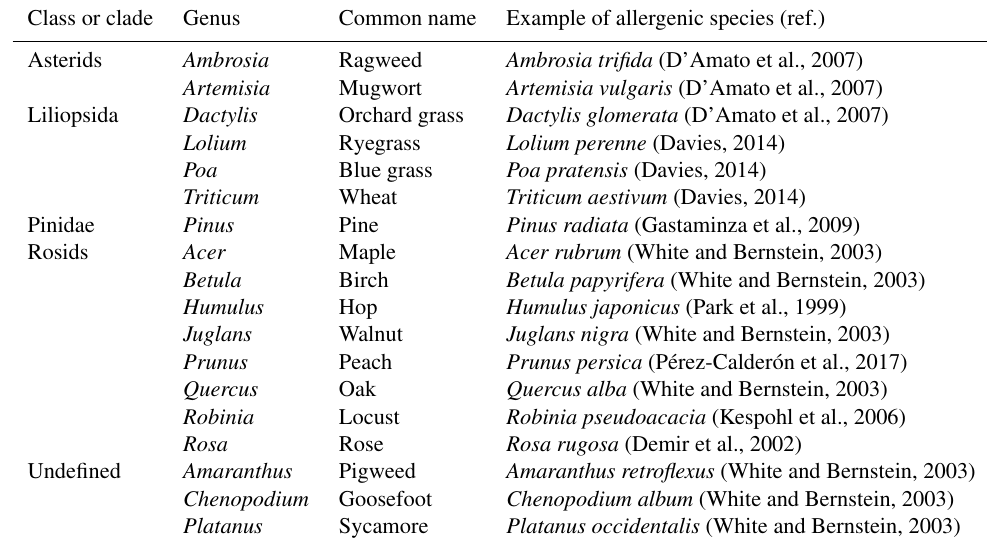
Example of allergenic species